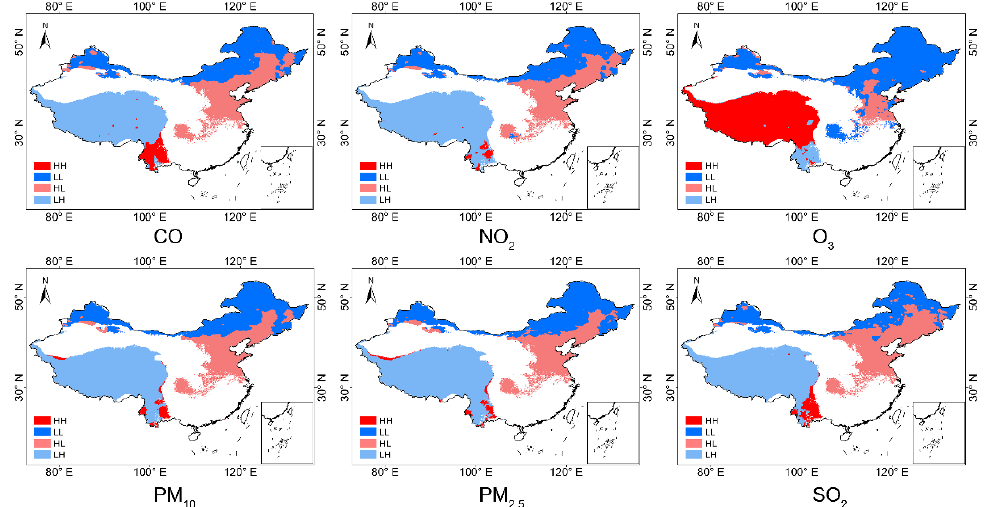
Figure 11. Bivariate LISA clustering of surface concentrations of six air pollutants and clear-sky POAI in 2018. The results passed the 95% significance test, and the white areas are the non-significant areas.